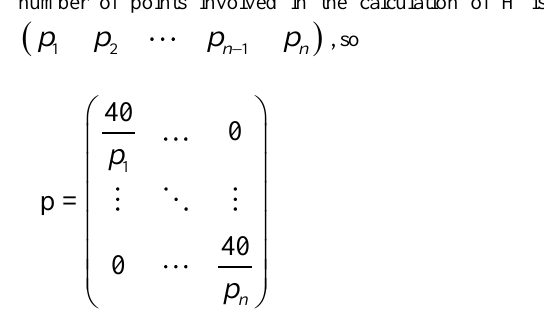
Figure 3. Process of mosaic